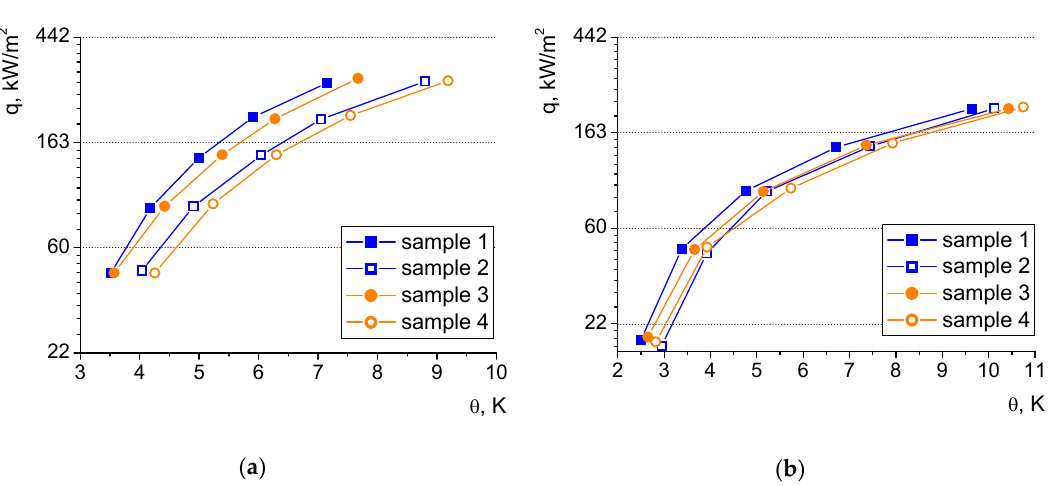
Figure 6. Heat flux vs. wall superheat for samples of different groove width and depth; ( a ) distilled water, ( b ) ethyl alcohol.